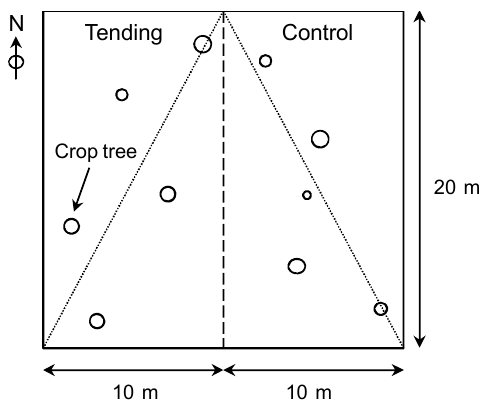
Figure 2. The division of original plots into two subplots for the tending experiment and the selection of crop trees for measuring